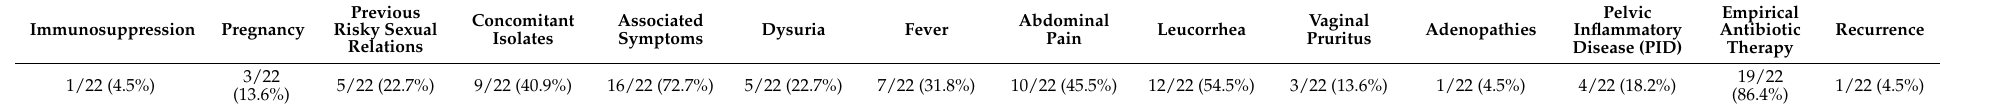
Table 1. Epidemiological and clinical variables corresponding to genital infection episodes in female adults.